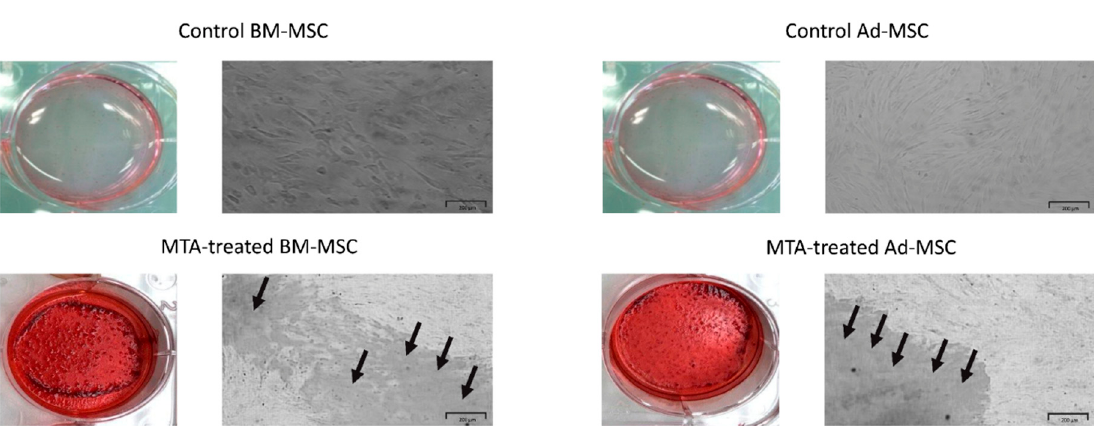
Figure 3. Investigating the effects of MTA-conditioned media on alkaline phosphatase activity (ALP) of human MSCs. ALP activity of ( a ) BM-MSCs and ( b ) Ad-MSCs following treatment with different concentrations of MTA-conditioned media after 14 days. Human MSCs incubated in 0.2 mg/mL MTA- conditioned media had significantly higher ALP activity compared to the control and other treated groups. Values are mean ± SD, n = 3, **** indicates p < 0.0001.